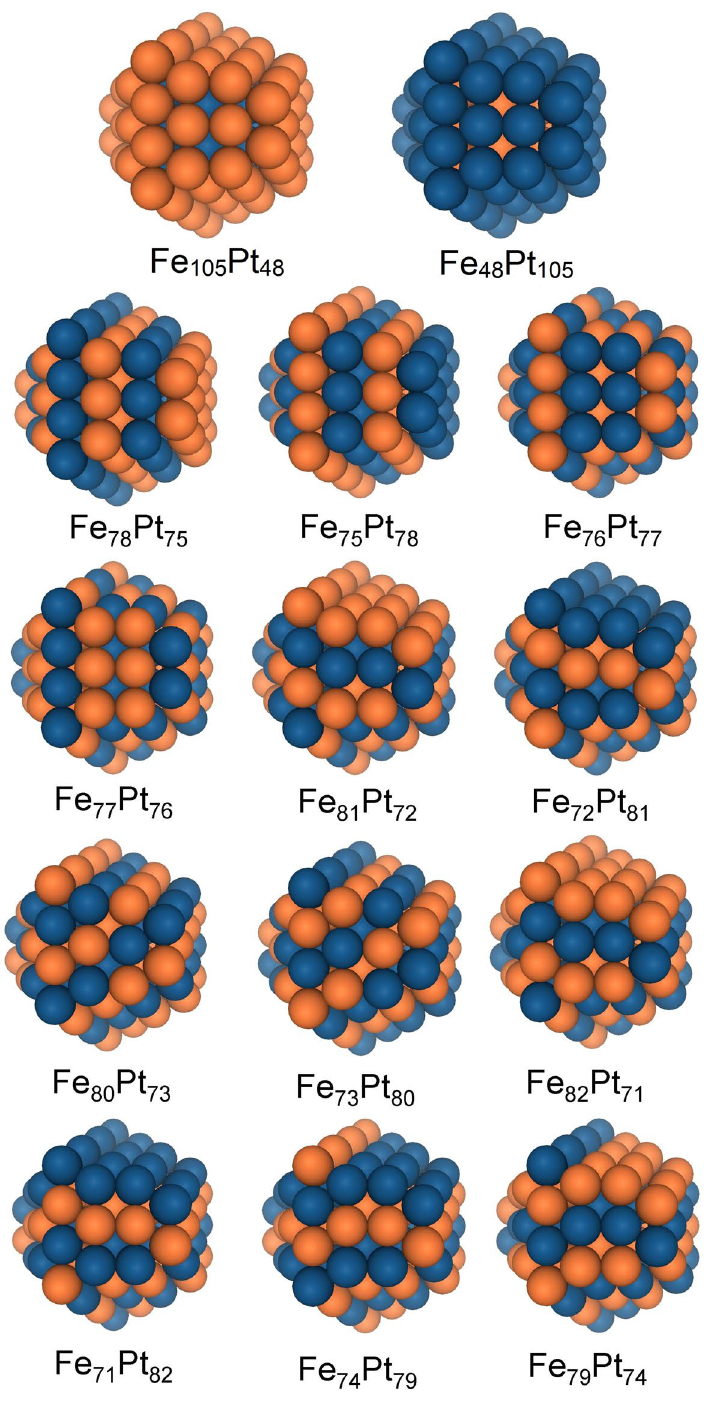
Figure 2. Selected hcp nanocluster models with initial